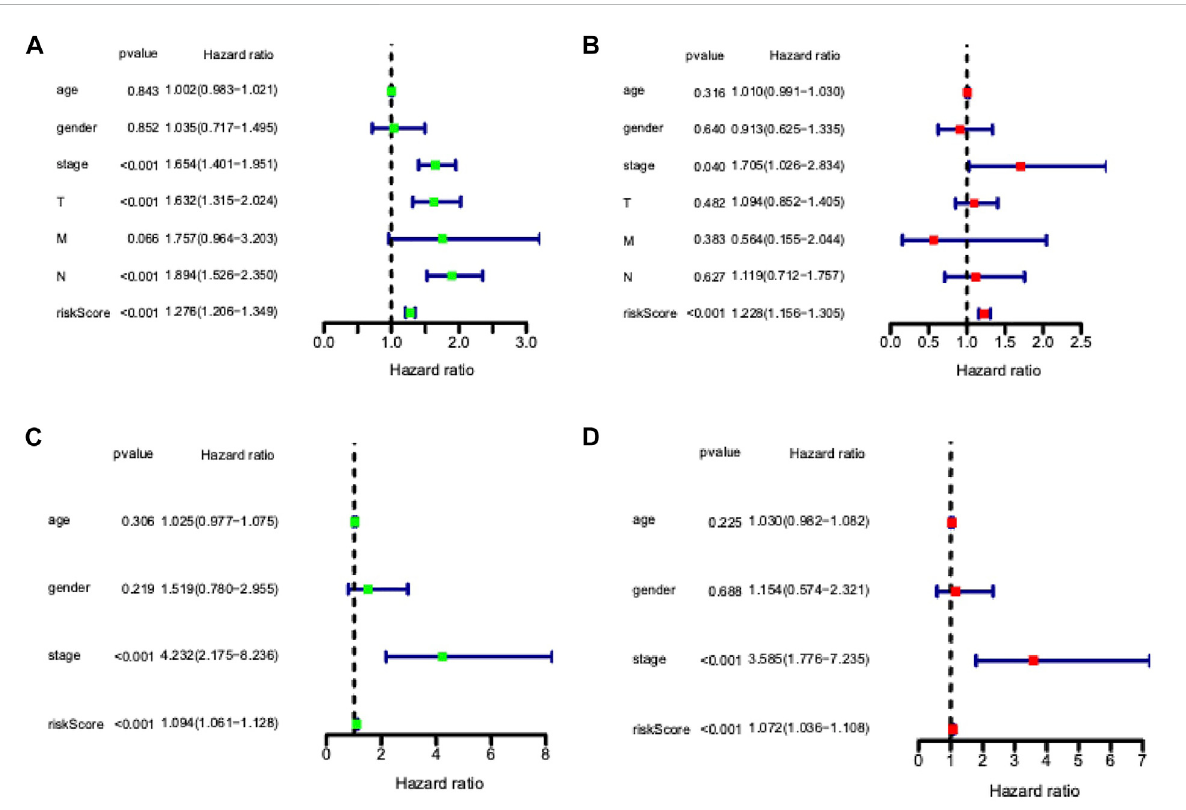
FIGURE 7 Independentprognostic ability evaluation for the constructed prognostic signature in LUAD. (A) Univariate Cox regression analysis of risk score and related clinical information regarding prognostic value in TCGA LUAD dataset. (B) Multivariate Cox analysis of risk model score and clinical features regarding prognostic value in the TCGA LUAD dataset. (C) Univariate Cox regression analysis of risk score and related clinical information regarding prognostic value in GSE dataset. (D) Multivariate Cox analysis of risk model score and clinical features regarding prognostic value in GSE